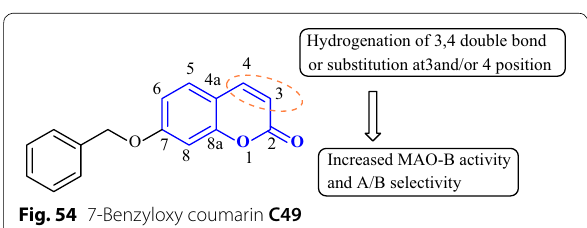
Fig. 54 7-Benzyloxy coumarin